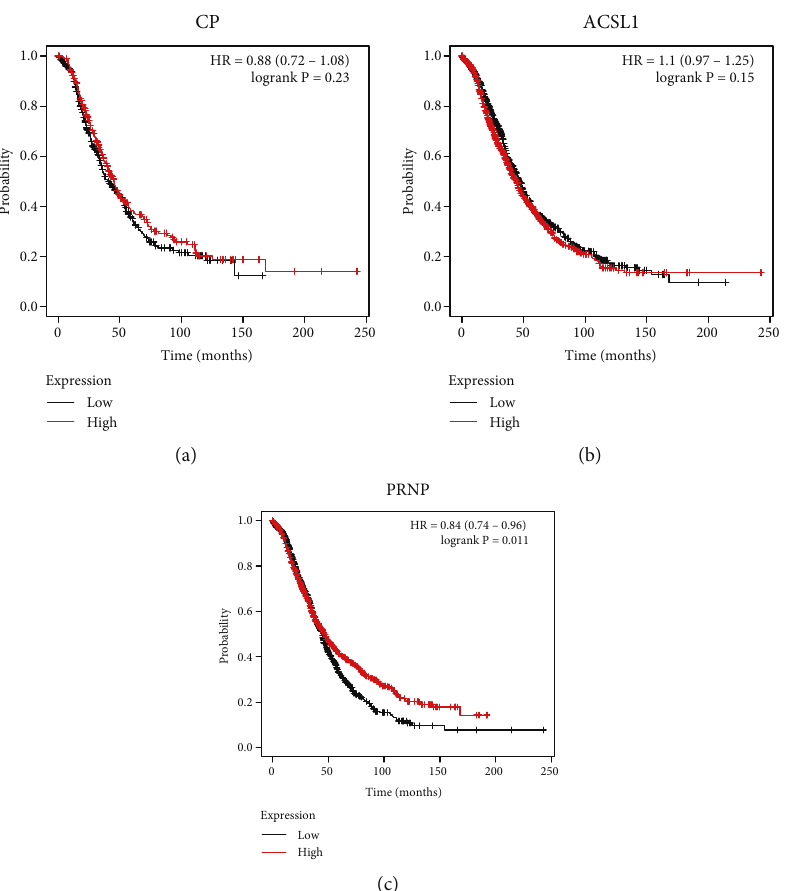
Figure 2: Survival analysis of the three di ff erentially expressed ferroptosis-associated genes in patients with OC (Kaplan-Meier Plotter). (a) The association between CP expression and overall survival. (b) The association between ACSL1 expression and overall survival. (c) The association between PRNP expression and overall